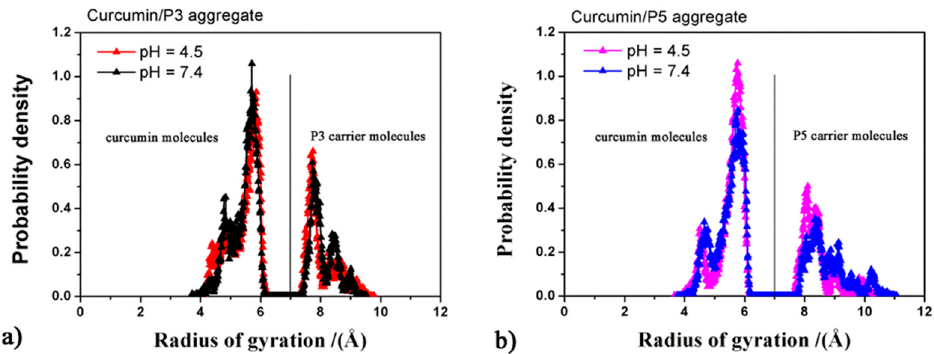
Figure 5. Radii of gyration of all molecules calculated during MD runs for the curcumin/P3 aggre- gates ( panel a ) and of the curcumin/P5 aggregates ( panel b ).